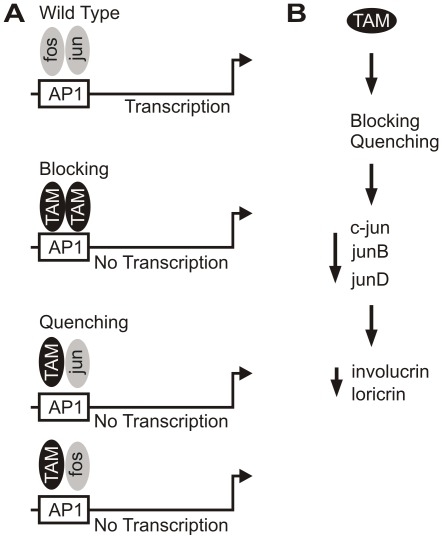
Mechanism of TAM67 action in keratinocytes.
A Wild-type regulation involves the binding of fos:jun heterodimers (and jun:jun hetero and homodimers, not shown) to AP1 response element to drive differentiation-associated gene expression. Blocking occurs when the concentration of TAM67 present in the cells is high enough that TAM67 homodimers comprise the major complex bound to DNA and this complex blocks interaction of endogenous AP1 factors with the element. Quenching occurs when TAM67 complexes with endogenous jun and fos factors and this complex, which is transcriptionally inactive, binds to DNA. We propose that blocking is a major mechanism of TAM67 action in our system, but that quenching is also important. B TAM67 interaction at the promoter elements leads to blocking and quenching to reduce AP1 factor interaction and activity at AP1 binding sites. This leads to reduced expression of jun factors and ultimately reduced target gene (involucrin, loricrin) expression.